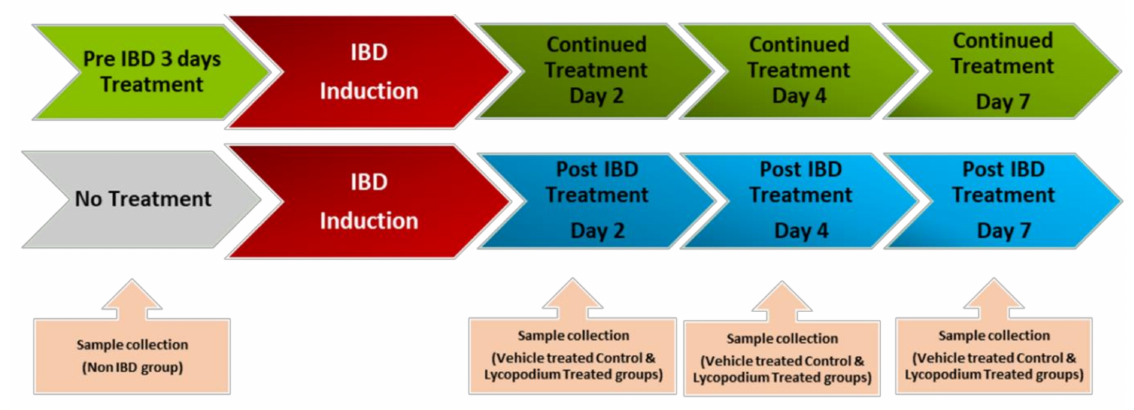
Figure 1. Schematic representation of study